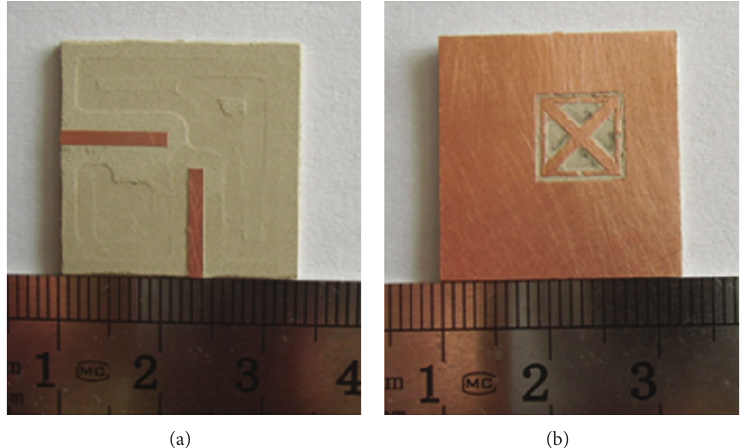
Figure 9: Photographs of proposed filter: (a) top view and (b) bottom view.